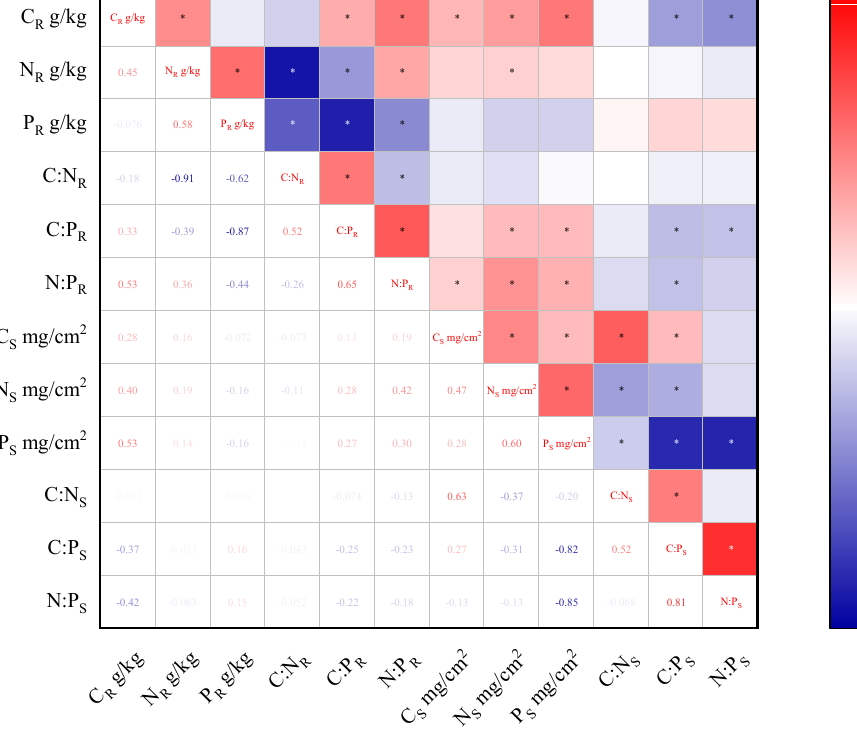
Figure 4. Correlations of nutritional indexes between root and soil. * Signifies significance. The value represents the correlation coefficient (r). The color column represents the range of correlation coefficients.